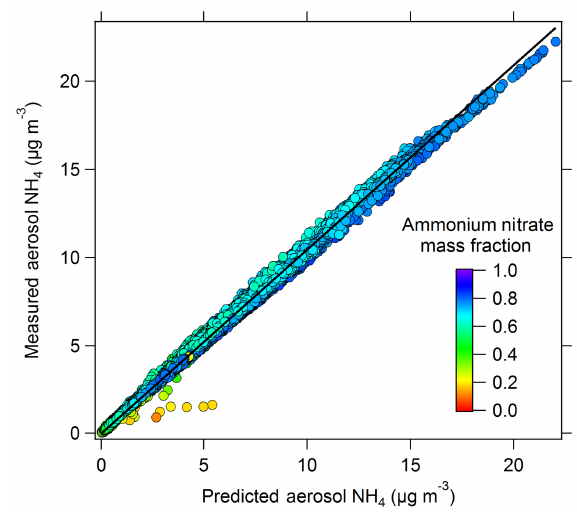
Figure 5. Aerosol ion balance from the AMS measurements. On the x axis is the calculated mass of ammonium for fully neutralized = 18 × (NO − / 62 + SO − / 96 × 2 + Cl − / 35 . 45)). On aerosols (NH + 4 3 4 the y axis is the measured ammonium (NH + ) in the aerosol par- 4 ticles. The black line is the 1 : 1 line, for which points on the line correspond to neutralized aerosols, and below the line are acidic aerosols. Data are color-coded by the ammonium nitrate mass frac-